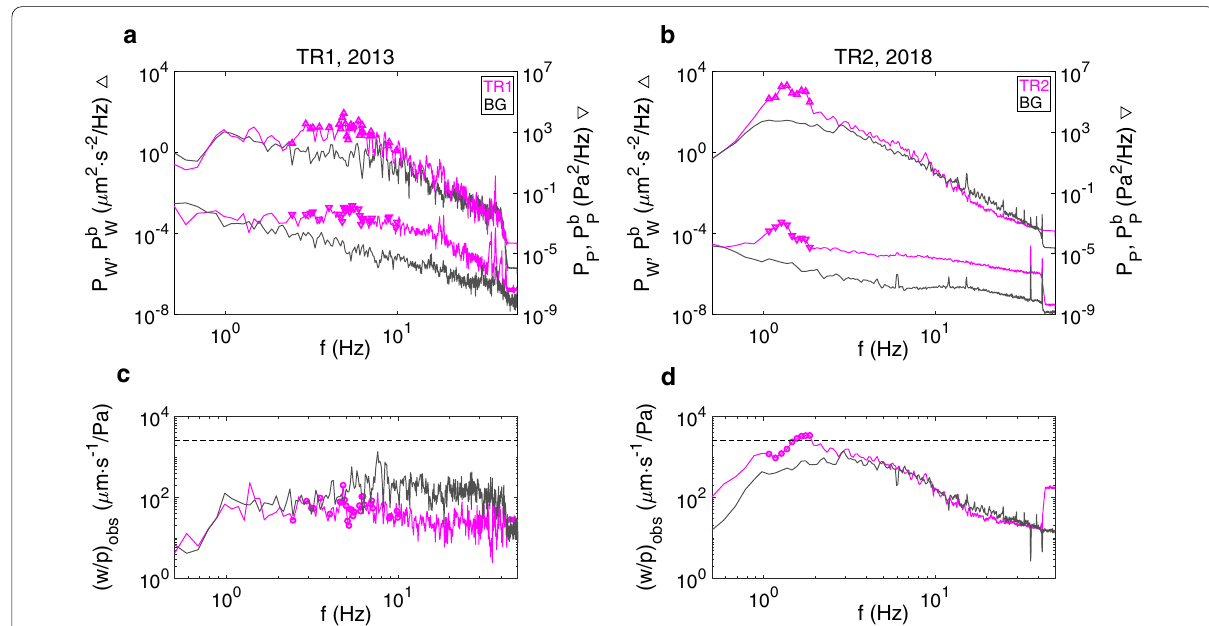
Fig. 3 Power spectral features of tremors (magenta) and background noise (black). The symbols show the values of the meaningful frequency bands selected by step ⑤ of the text. a , b The upper magenta line with the upward triangles is P W , and the associated black line is P b W , on the left axis. The lower magenta line with inverted triangles is P P , and the associated black line is P b P , on the right axis. c , d The spectral amplitude ratio between seismic record and infrasonic record, ( w / p ) obs , as a function of frequency. The horizontal dashed line indicates the theoretical value for the ground-to-atmosphere wave calculated by Eq. (2) with α 340 m/s and ρ 1.16 kg/m = =